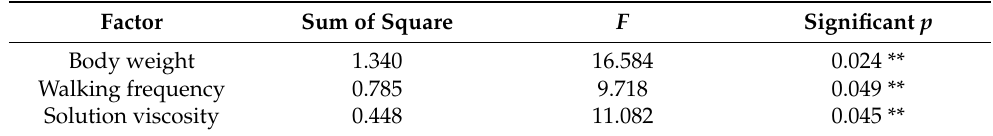
Table 4. Three-factor ANOVA with a as the indicator. Factor Sum of Square F Significant p Body weight 1.340 16.584 0.024 ** Walking frequency 0.785 9.718 0.049 ** Solution viscosity 0.448 11.082 0.045 **